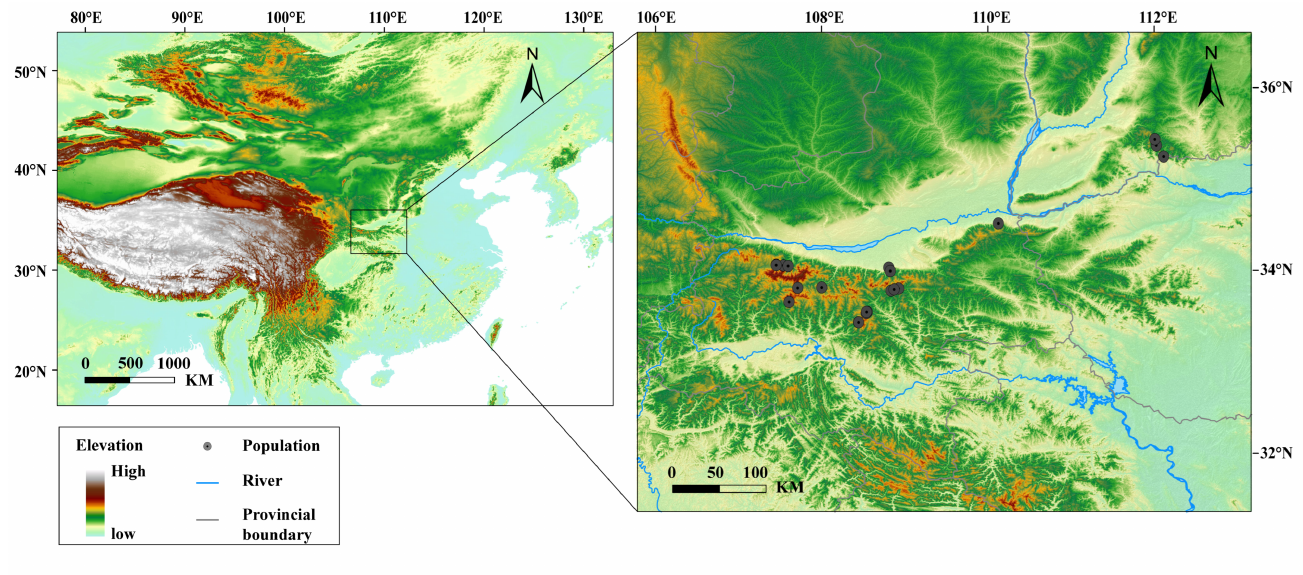
Figure 1. Geographic distribution of the studied populations for Feriana taihangnica